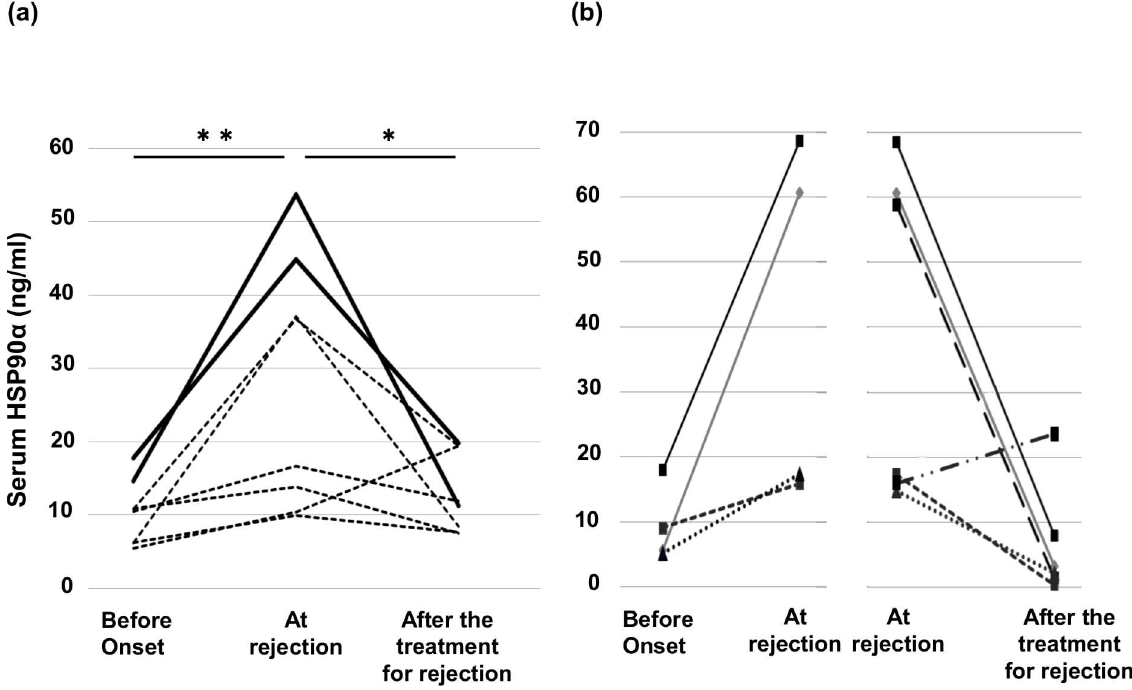
Fig 2. Kineticsof serum HSP90 α before and afteracuteT-cell-mediated rejection(a) and acuteantibody-mediated rejection(b). In most patients, serumHSP90 α levels increased afterthe onset of acute rejectioncomparedto those before onset and decreased to baselineaftertreatment.(a) Results of serialmeasurementof serumHSP90 α in eight patientswith acute T-cell- mediatedrejection.Patients with Banff type II (black line) had a higherlevel at rejectionthan those with type I (dottedline).(b) SerumHSP90 α was measuredin four patientsbefore onset and at rejectionand was measuredin six patientsat rejection and after treatment.Values aftertreatmentin the formerfour patientsand baselinevalues in the lattersix patientswere not available. * p < 0.05, ** p <